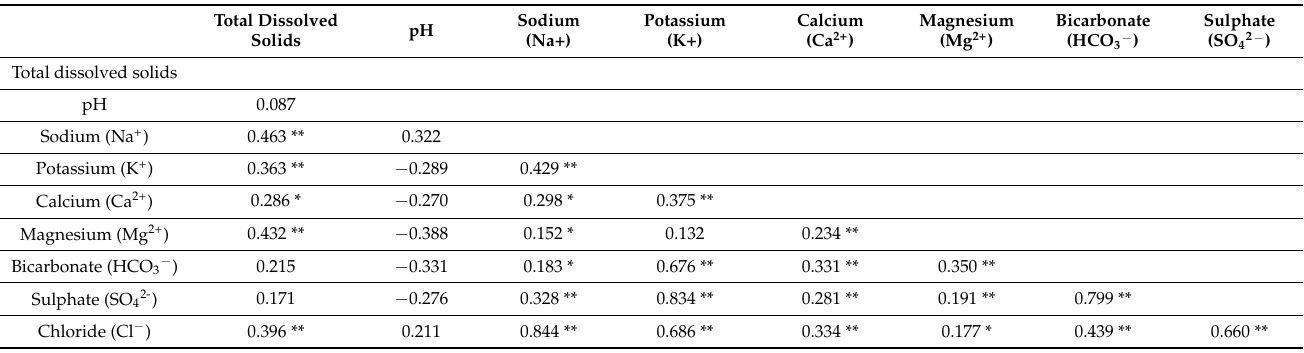
Table 1. Correlation matrix between the physico-chemical characteristics of spring waters in the 377 Sardinian